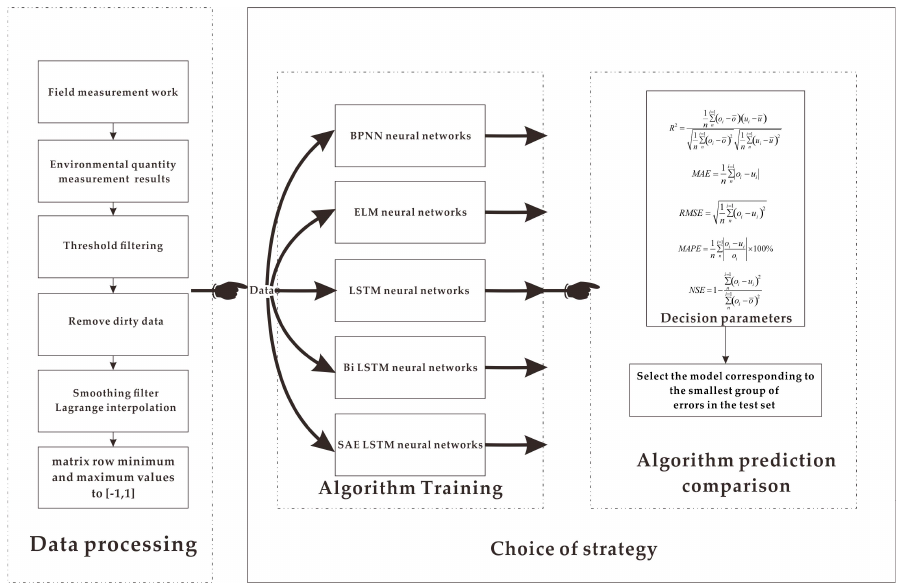
Figure 4. Data cleaning, standardization before data input into the network, and machine learning training and preliminary results comparison flowchart.